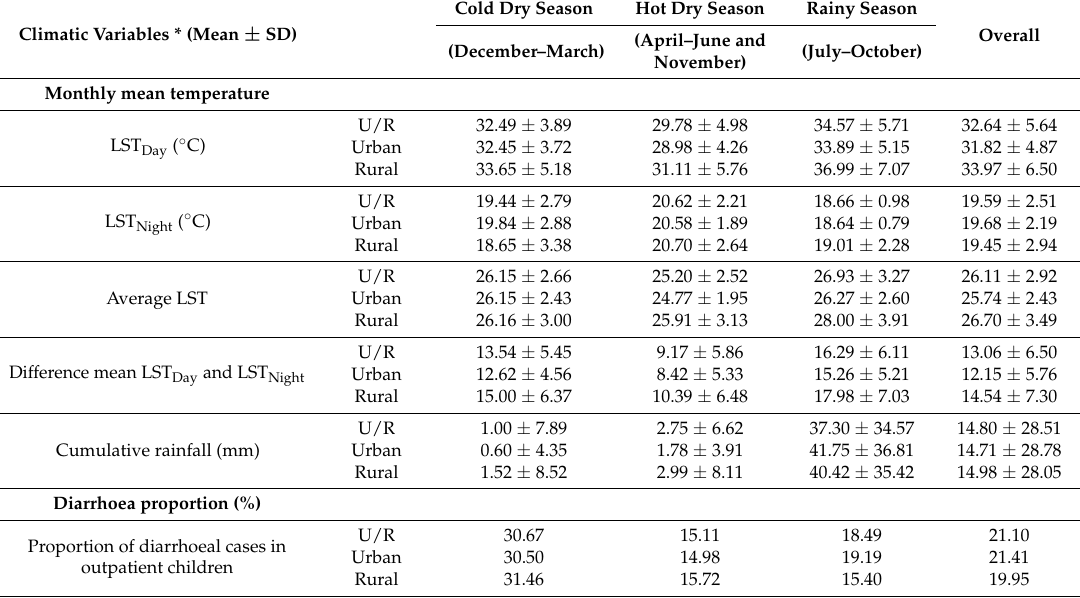
Table 2. Study parameters summarized for both areas combined (U/R), urban (U) and rural (R) in the health district of Mbour, Senegal and seasonal calendars extracted for the study period 2011–2014.